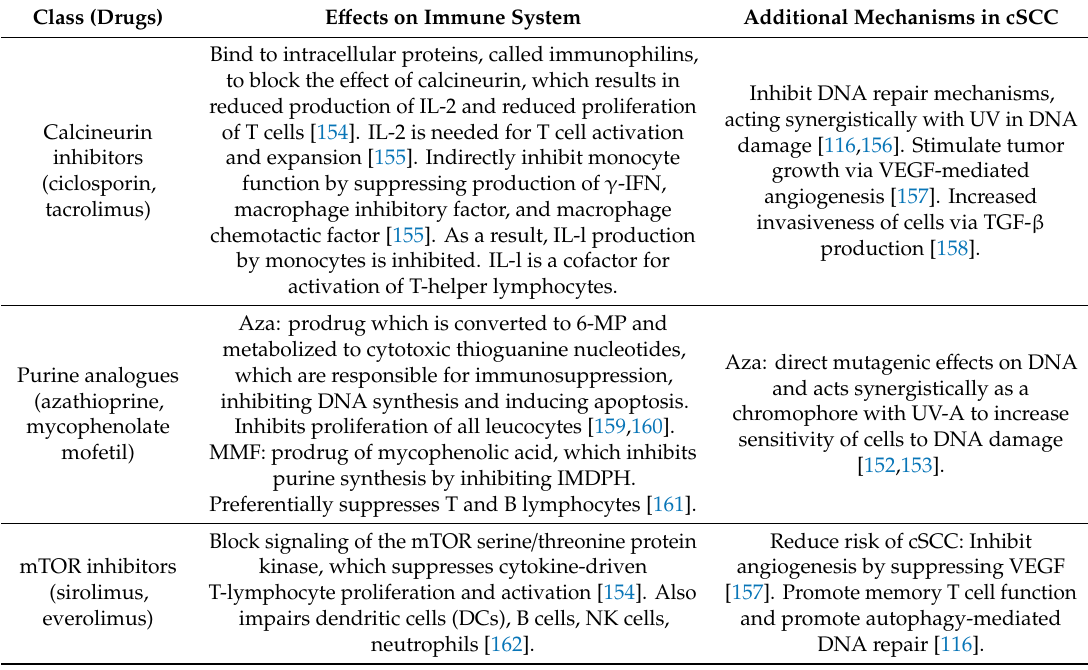
Table 2. Summary of the main classes of immunosuppressant drugs, their main e ff ects on the immune system and additional mechanisms at play in cSCC pathogenesis. 6-MP, 6-mercaptopurine; Aza, azathioprine; IL, interleukin; IMDPH, inosine monophosphate dehydrogenase; mTOR,